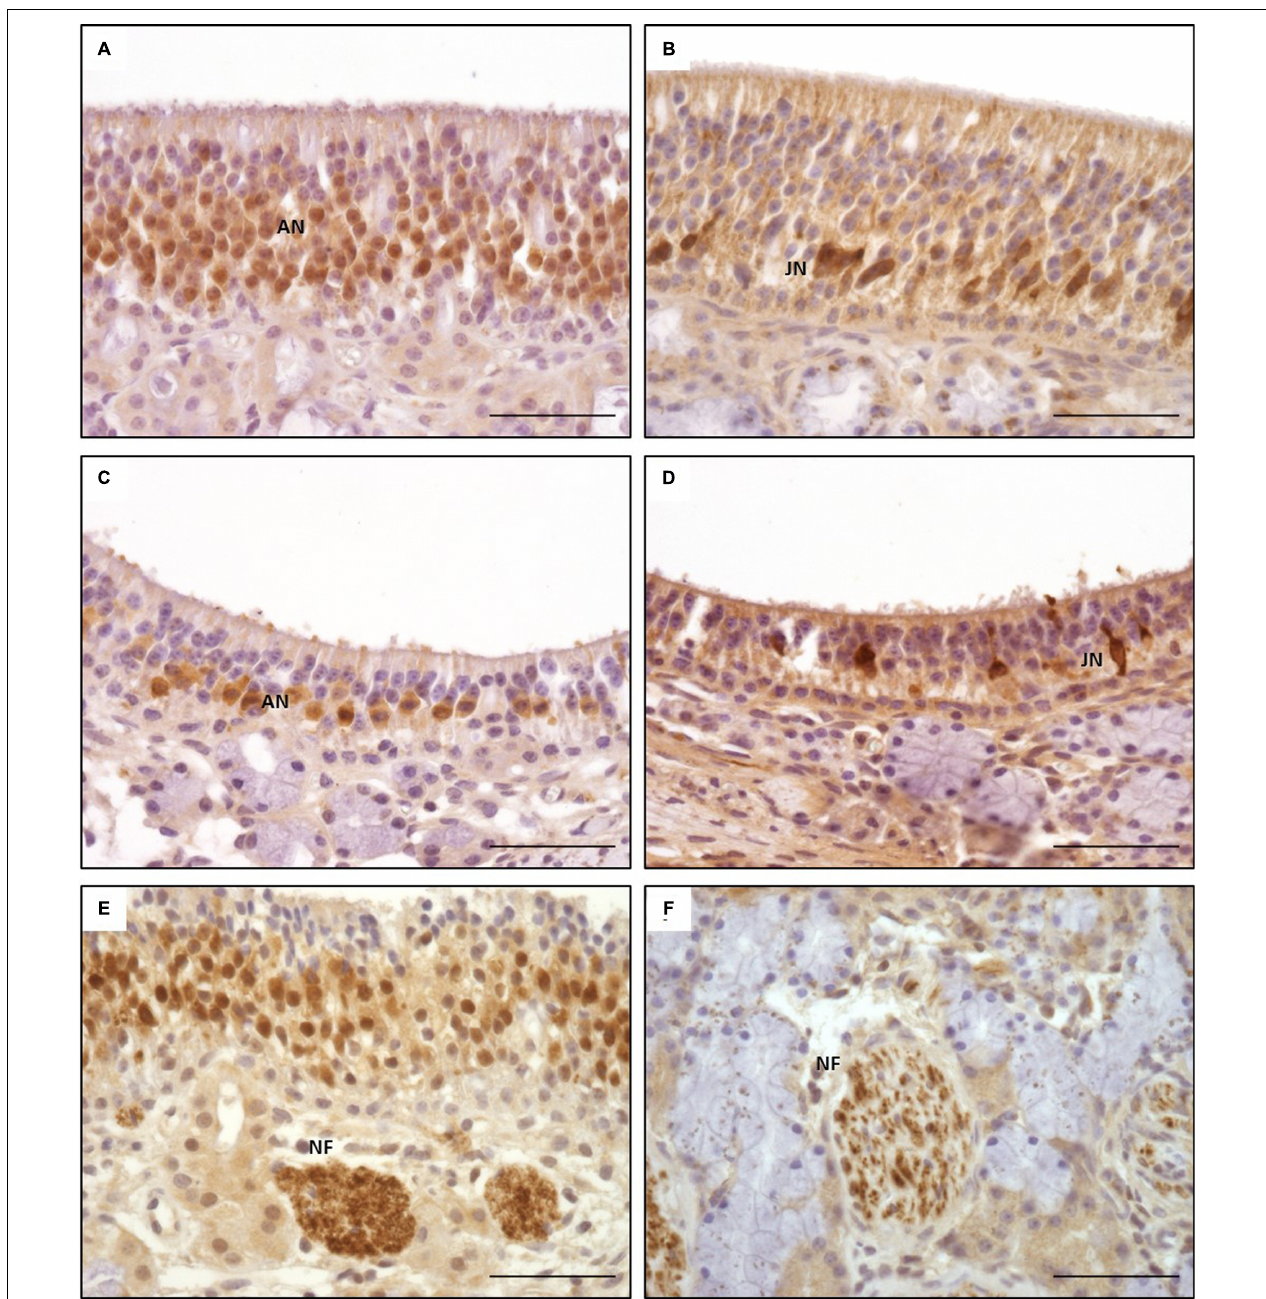
FIGURE 5 | Immunohistological detection of olfactory marker protein (OMP; A,C,E) and doublecortin (DCX; B,D,F); (A,B) olfactory epithelium type a; (C,D) olfactory epithelium type b; (E,F) nerve fibers in lamina propria; OMP staining of nuclei of adult olfactory neurons dominating in OE type a (A), pronounced staining of cytoplasm in type b (C); DCX staining of nuclei and cytoplasm of juvenile olfactory neurons in both types of OE (B,D); ANs, adult neurons; JNs, juvenile neurons; NFs, nerve fibers; scale bar: 50 µ m.